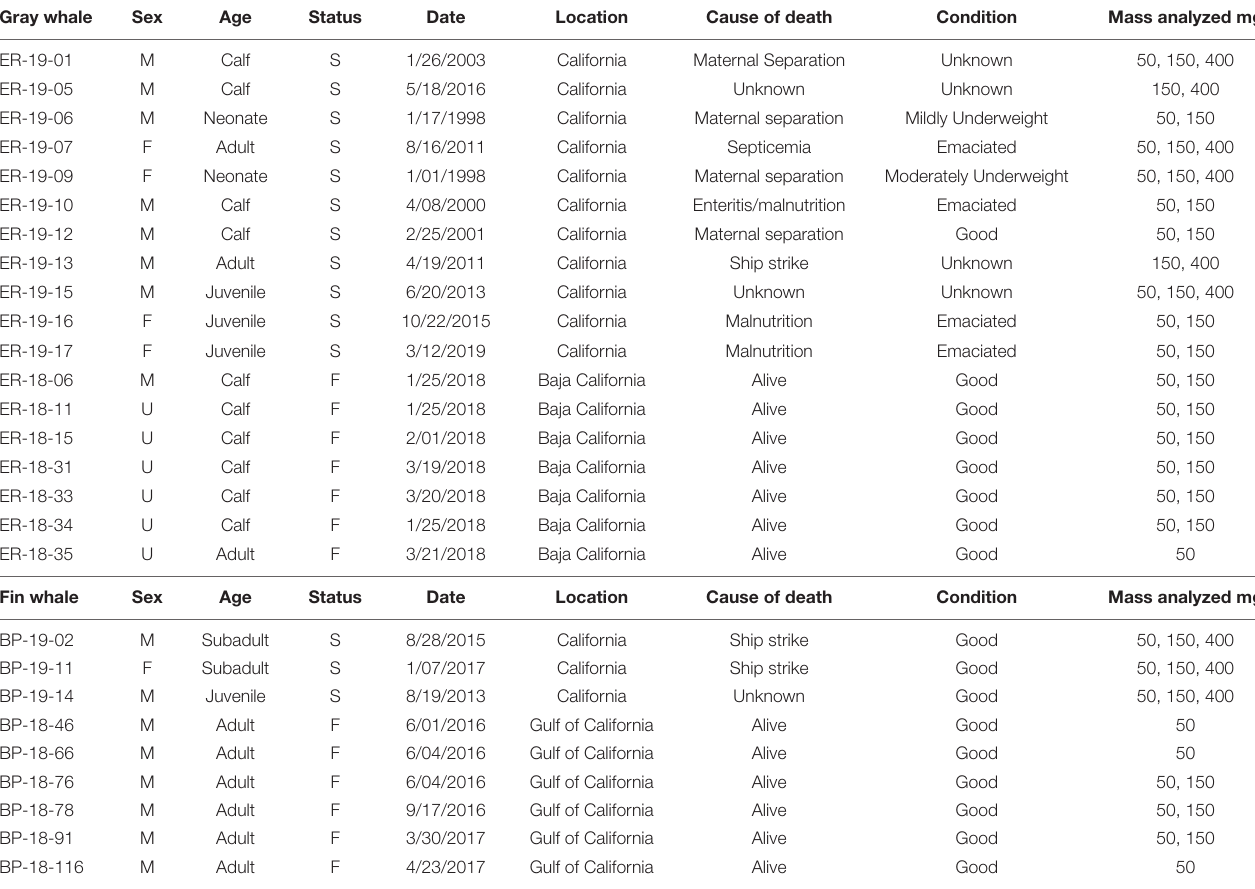
TABLE 1 | Life history parameters of gray and fin whales. Gray